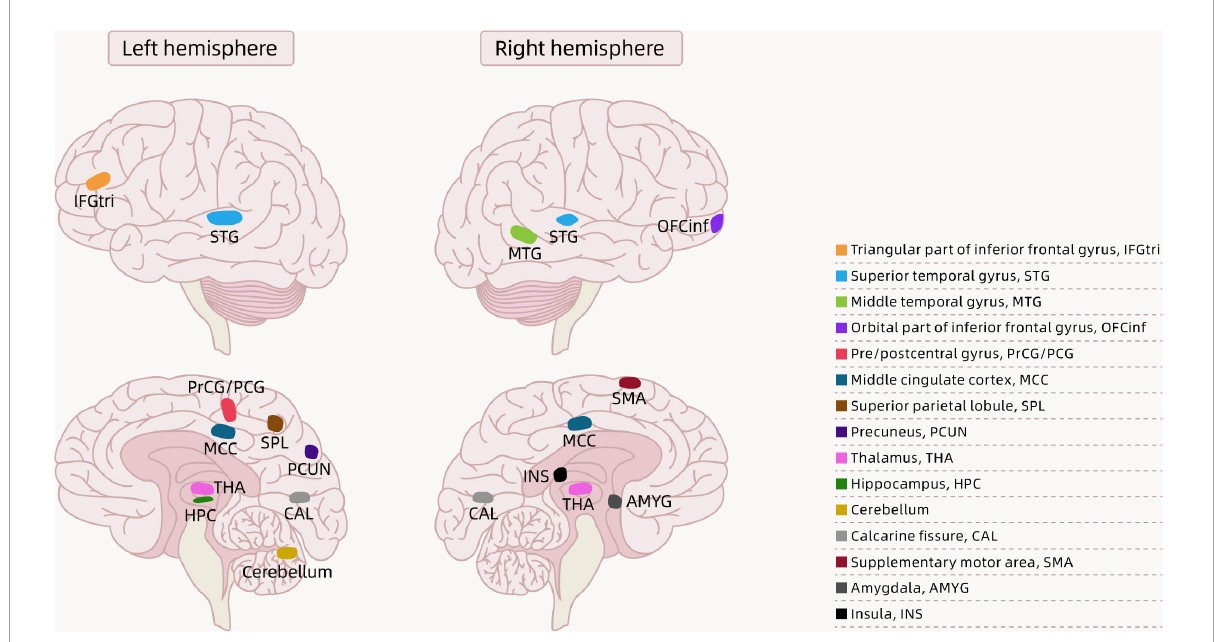
FIGURE1 Brain regions showing the differences between obese children and normal-weight children in the